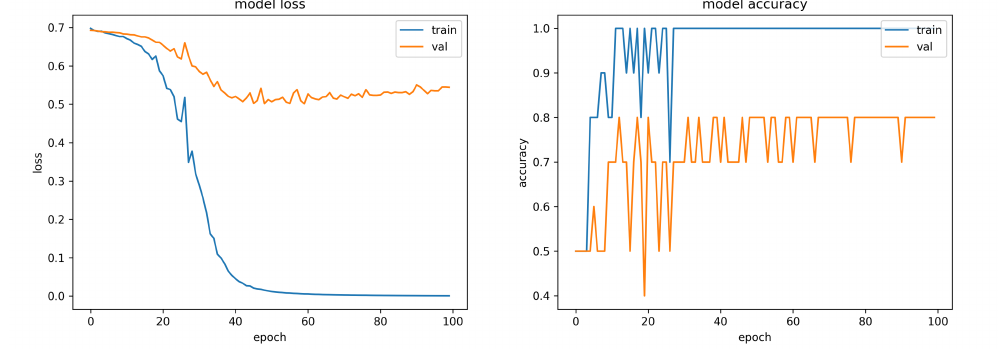
Figure 6. Loss and accuracy values of the model trained through the Conv2d model.